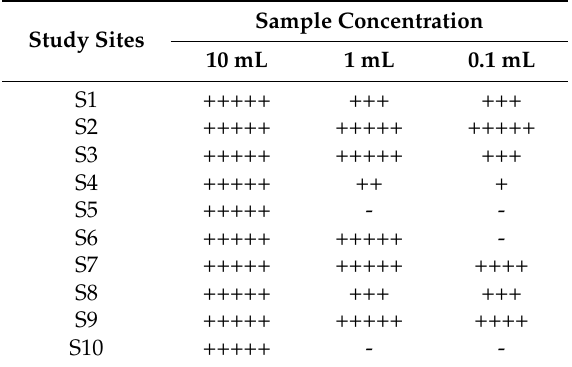
Table 4. Completed test for measuring the growth of Escherichia coli on EMB agar medium. Study